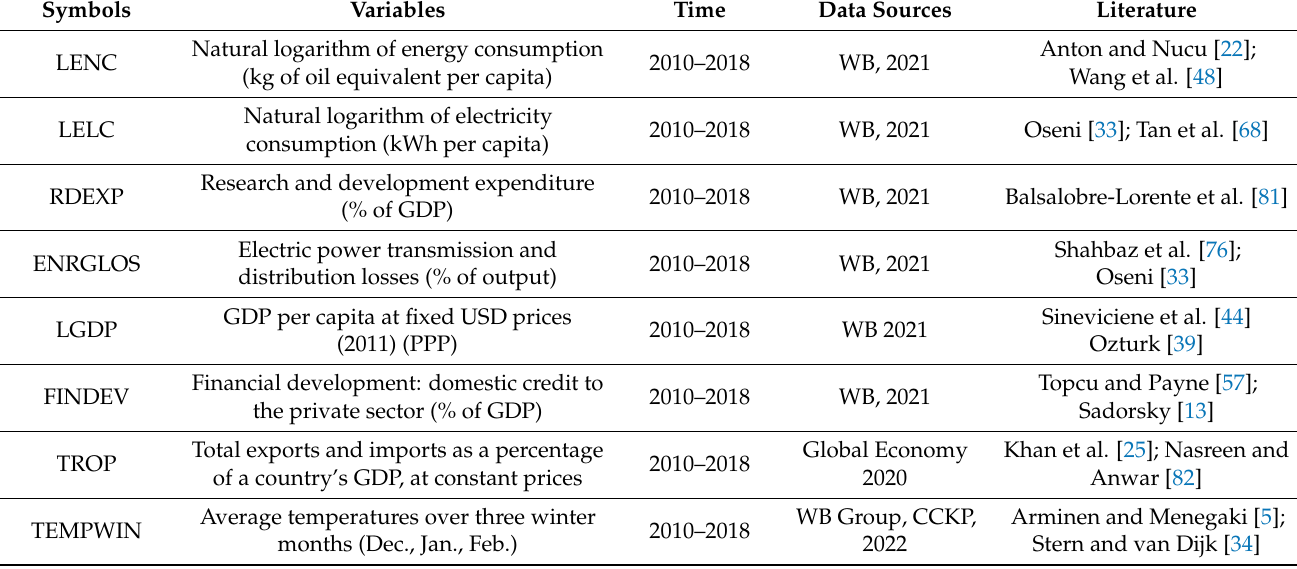
Table 3. Variables, Symbols, Literature, Data descriptions, and